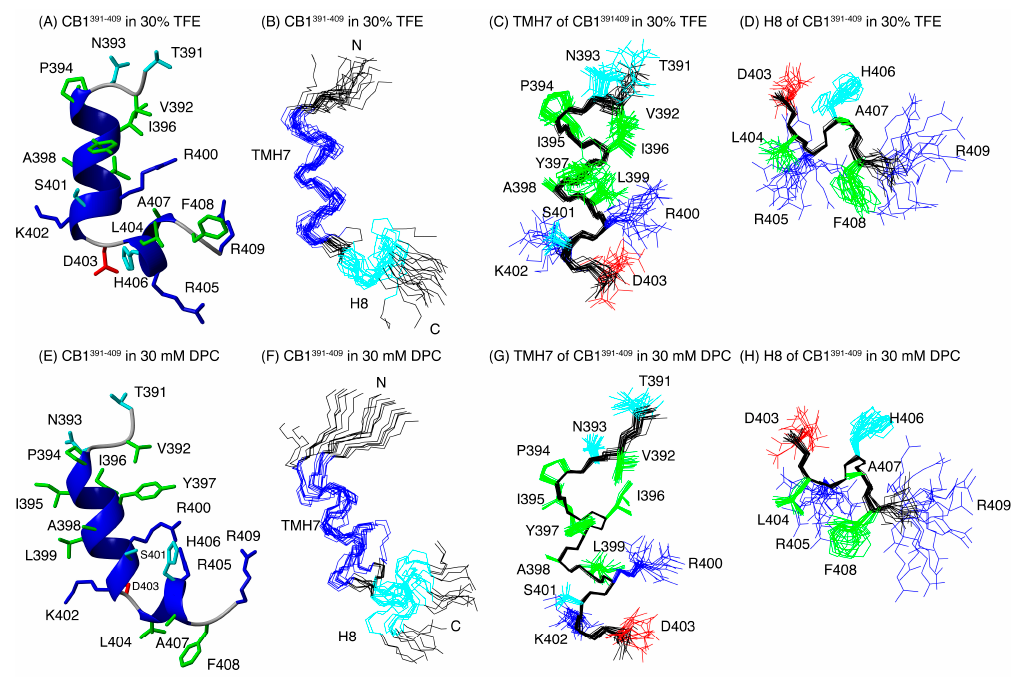
Figure 4. CB1 391-409 structure in 30% TFE ( A – D ) and in DPC micelles ( E – H ).) Ribbon representation of the lowest target conformer of the structural ensemble (A, E). Overlay of the backbone atoms of the 20 lowest target function conformers ( B , F ). Overlay of residues 394-402 (helix TMH7; panels C , G ) Overlay of residues 403-407 (helix H8; panels D and H ). In panels A – E , the backbone atoms of helices TMH7 and H8 are coloured in blue. The side-chains are shown in panels F – H . The aliphatic and aromatic side chains are displayed in green, the Glu and Asp side chains in red, the Arg and Lys side chains in blue, and the Asn, His, Thr, and Ser side chains in cyan.